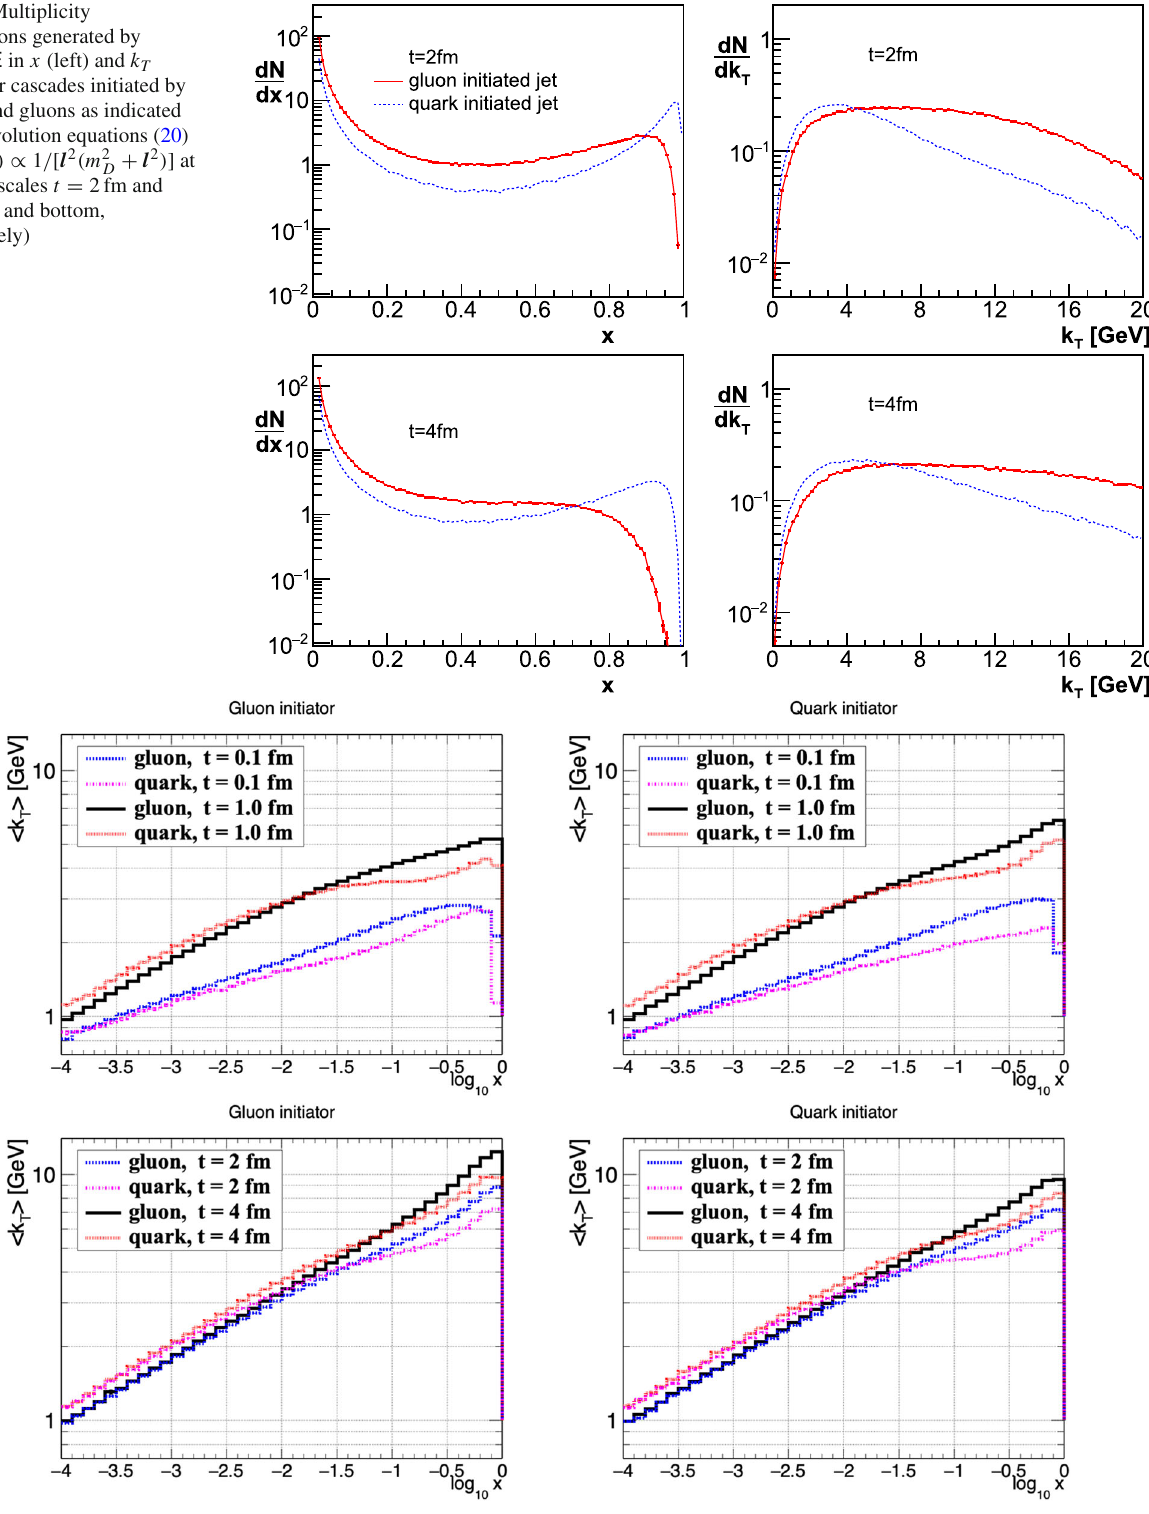
+ l 2 ) ] for the time-scales D